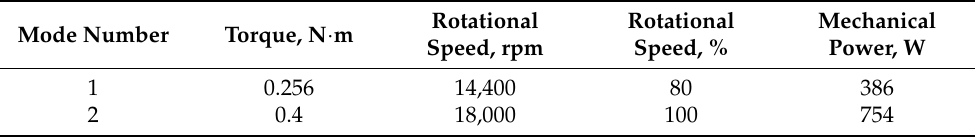
Table 1. Loading points of the flux reversal motor